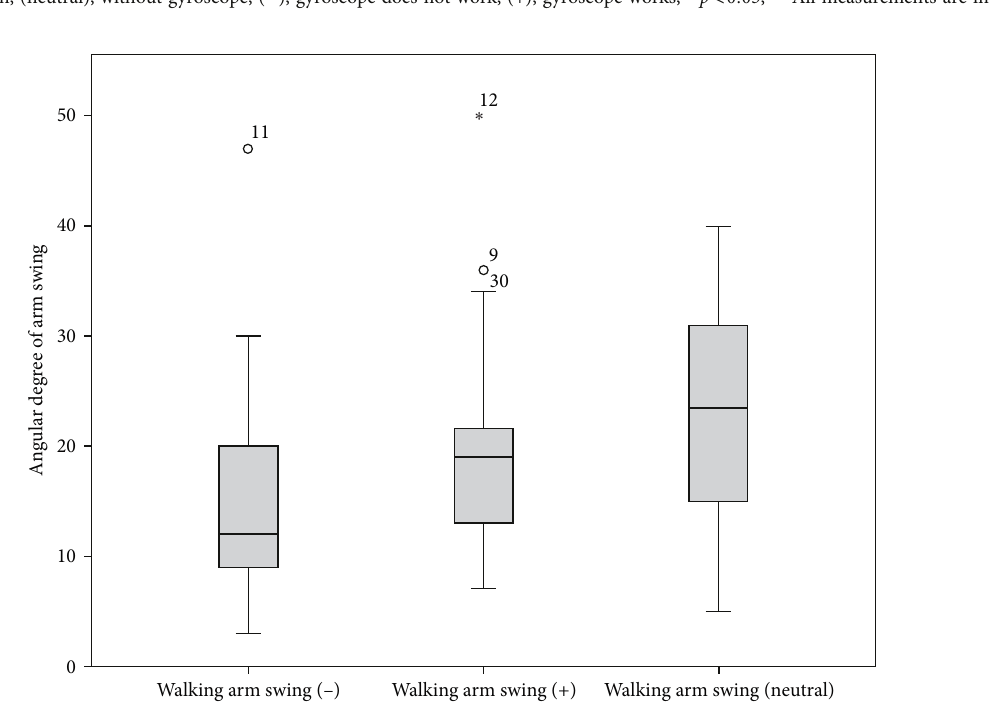
F IGURE 3: Box plots of the distribution of walking arm swing